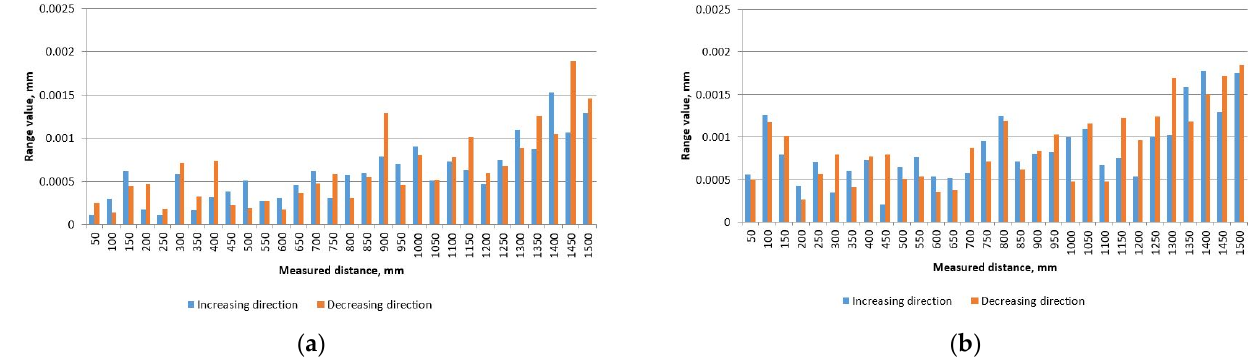
Figure 5. The values of the intervals between cycles in both directions: ( a ) inactive motors; ( b ) active motors.